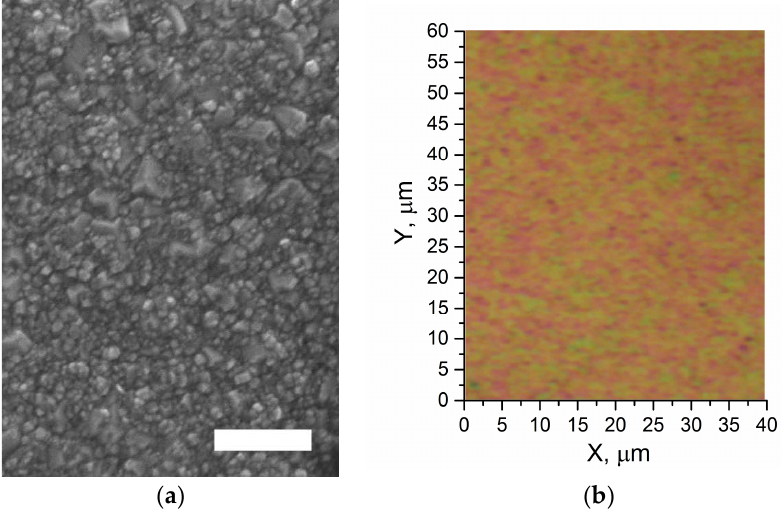
Figure 3. SEM, scale bar is 0.5 μm ( a ), and optical image of the CVD DND(Eu) film surface ( b ). The image ( b ) has been done at magnifying 50.